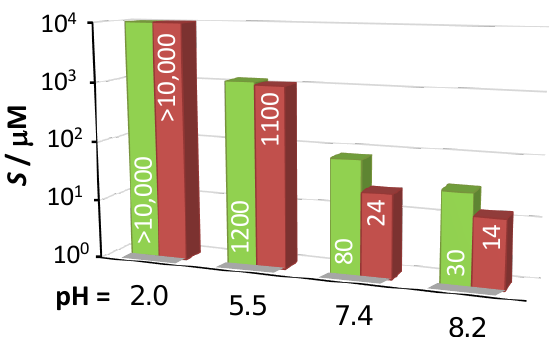
Figure 2. Thermodynamic solubility (S) of IMA at various pH values at 25 °C (green) and 37 °C (red), determined by UV-vis spectrophotometry [buffering solutions: 0.01 M HCl (pH = 2.0), 20 mM MES (pH = 5.5), 20 mM HEPES (pH = 7.4 and 8.2)].